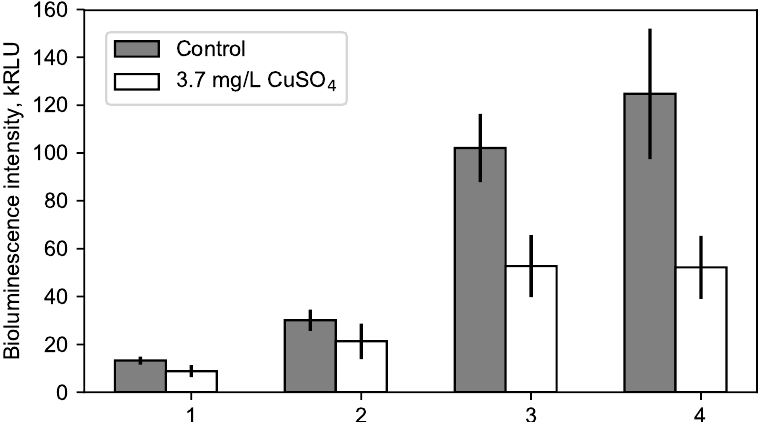
Figure 3. The enzyme system composition in a microfluidic chip was optimized to achieve higher luminescence intensity. Four different compositions were tested (Table 1). The standard composition (1) contained 0.14 µ g of luciferase and 52.3 × 10 − 6 activity units of NAD(P)H:FMN-oxidoreductase, 0.00044% of aldehyde, 0.11mM of NADH and 4mM of FMN. Composition (2) contained a doubled concentration of aldehyde, composition (3) in addition contained 35% increased concentration of enzymes and composition (4) in addition contained doubled concentration of